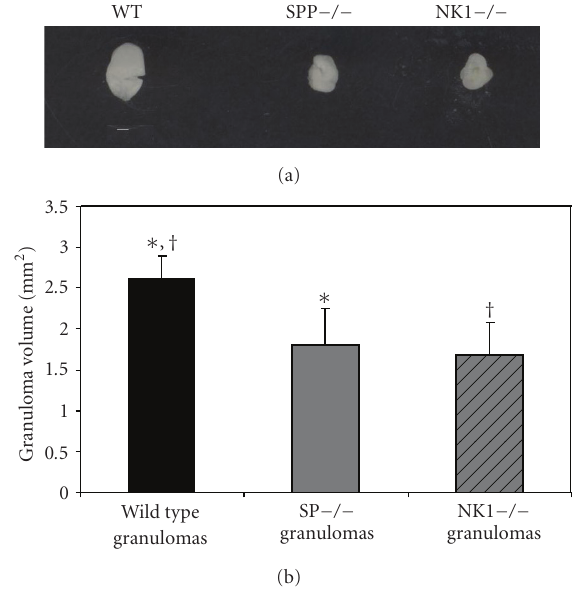
Figure 1: (a) Representative granuloma derived from infected WT, SPP-knockout, and NK1-knockout mice (white bar = 1mm). (b) Volumes of granulomas derived from Taenia crassiceps infected, wild type ( n = 2) versus SPP-knockout ( n = 4) and NK1-knockout mice ( n = 3). Data presented are mean ± SD; ∗ P < 05, size of infected, SPP-knockout derived granulomas versus WT derived granulomas, † P < . 05, size of infected, NK1-knockout derived granulomas versus WT derived granulomas.